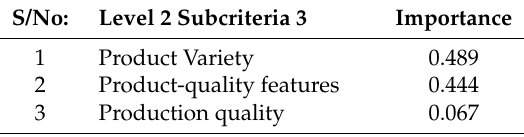
Table 6. Level 2—subcriteria 3.